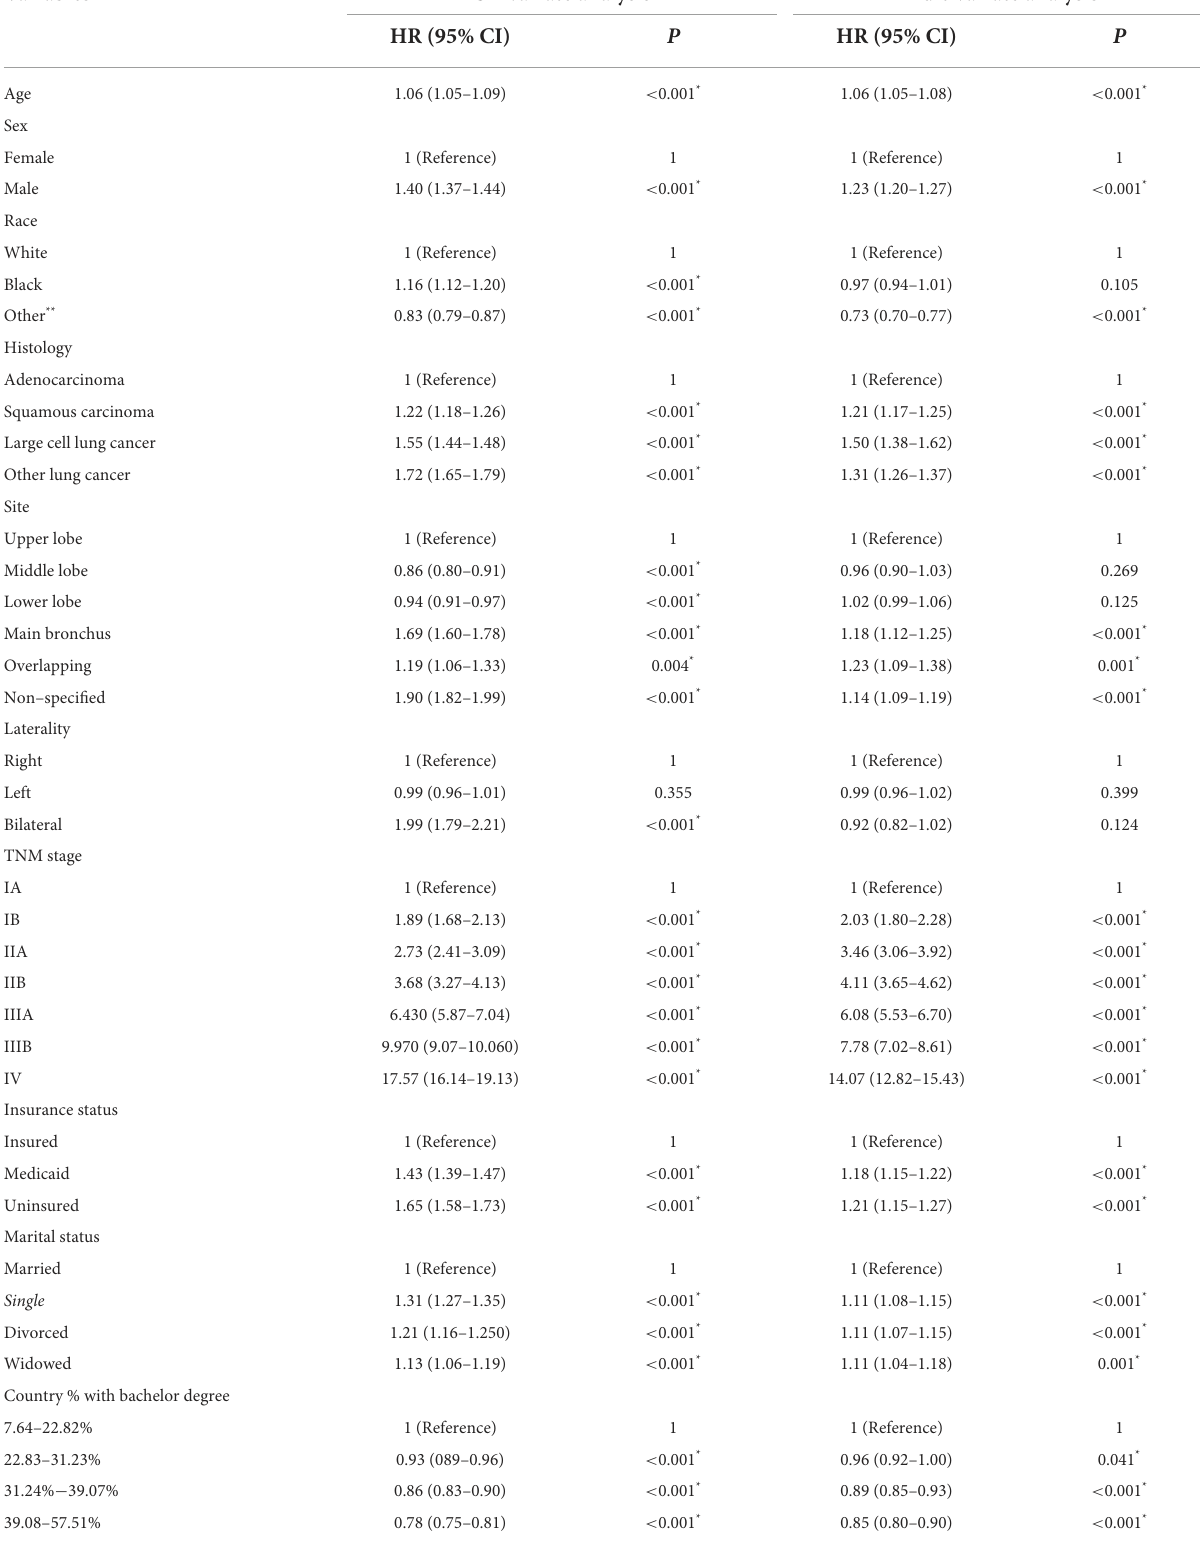
TABLE 2 Univariate and multivariate analysis of CSS of patients with